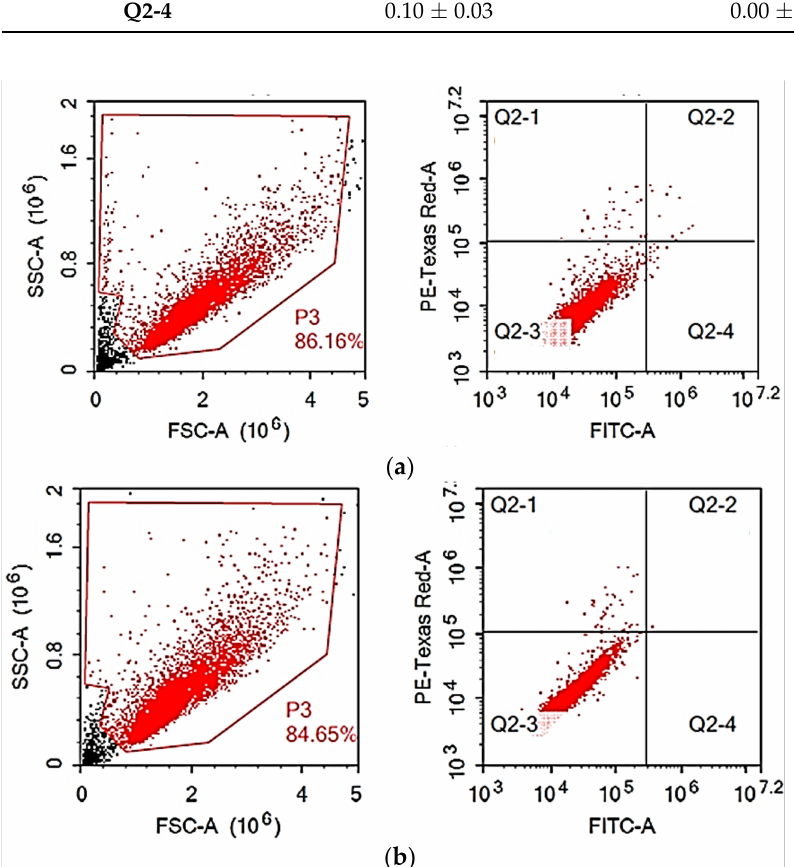
Figure 5. Apoptosis/necrosis estimation in MCF7 cells after treatment with A. tenuissima extract